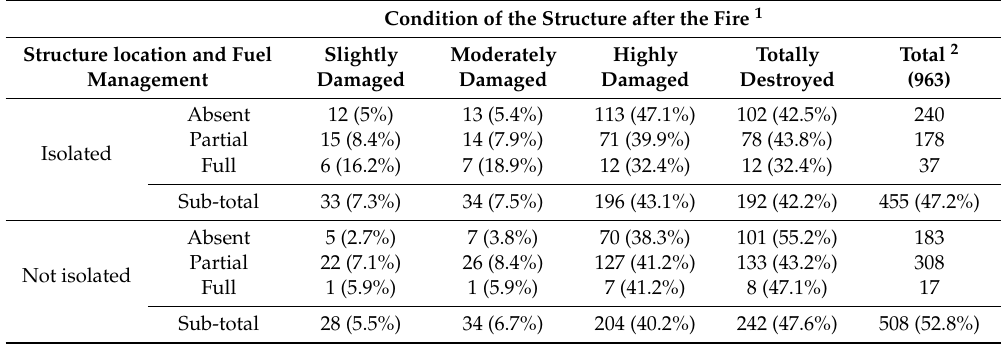
Table 9. Degree of damage according to the relative house location and fuel